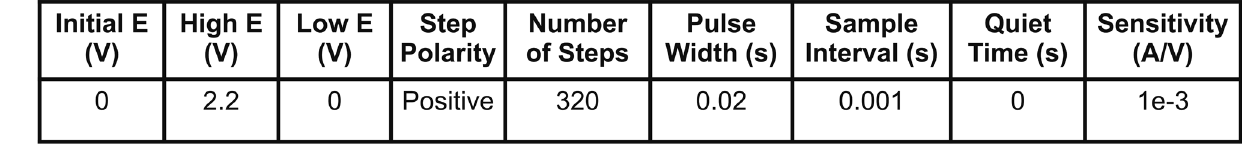
Table 2. Chronoamperometry parameters for electrochemically roughening to electrodes in 0.5 M H 2 SO 4 . Here, we repeat this procedure 50 times to increase the electrode surface